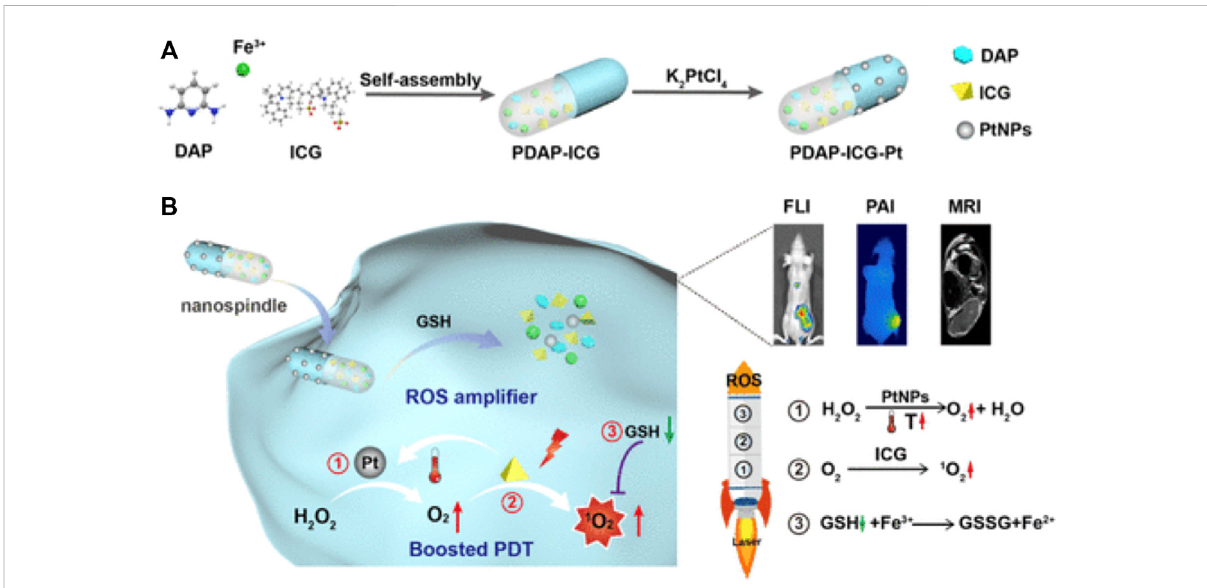
FIGURE 3 Illustration of the cascade strategy for enhanced PDT using rationally designed Nanofusiforms as a ROS ampli fi er; (A) synthesis of PDAP – ICG – PtNanofusiforms; (B) modulatingthetumormicroenvironmentforenhancedPDTef fi cacy via nanoyzme-catalyzedandheat-improved oxygen self-supply to keep sustainable high ROS levels and antioxidant depletion to prevent PDT tolerance (Dong et al., 2021). Copyright © 2021 American chemical